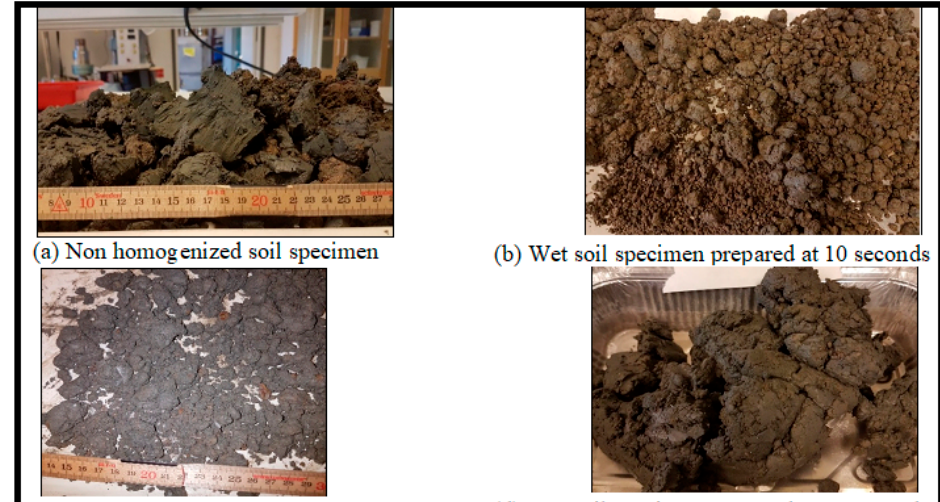
Figure 4. Visual evaluation of Soil 2 before and after disintegration at various time: ( a ) Non homogenized soil specimen; ( b ) Wet soil specimen prepared at 10 seconds; ( c ) Wet soil specimen prepared at 13 seconds; ( d ) Wet soil specimen prepared at 16 seconds.